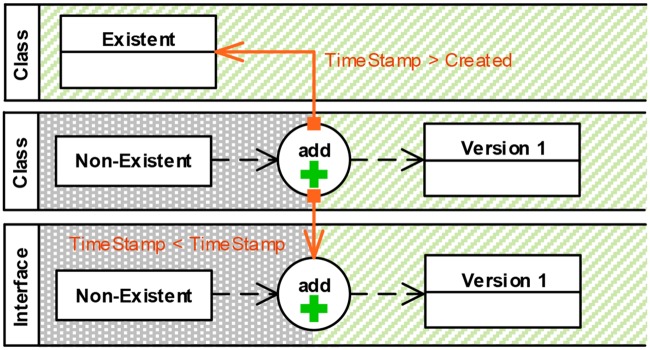
Visual representation: Sequence constraints (C5).